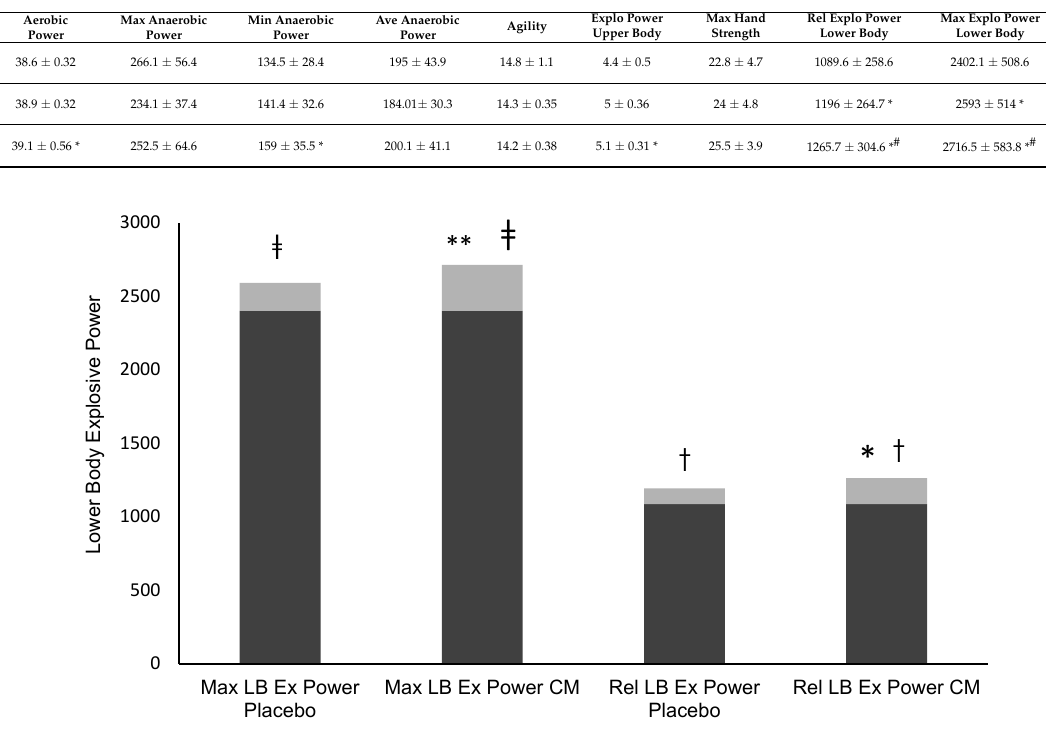
Table 3. Subjective measurements of YOYO intermittent test (Time To Exhaustion (TTE), aerobic power (VO 2max (mL/min/kg))), RAST test (maximum anaerobic power (Watt), minimum anaerobic power (Watt), average anaerobic power (Watt)), SEMO Test (Agility (sec)), medicine ball throw test (explosive power of the upper body (meter)), handgrip dynamometer (max hand strength (kg)), Vertical Jump Test (relative explosive power of the lower body (Watt), maximum explosive power lower body (Watt)) on baseline, post-test placebo and post-test LFCM. Values are mean ± SD ( p < 0.05) (* = Significantly different ( p < 0.05) from baseline, # = significantly different ( p < 0.05) from post-test placebo).